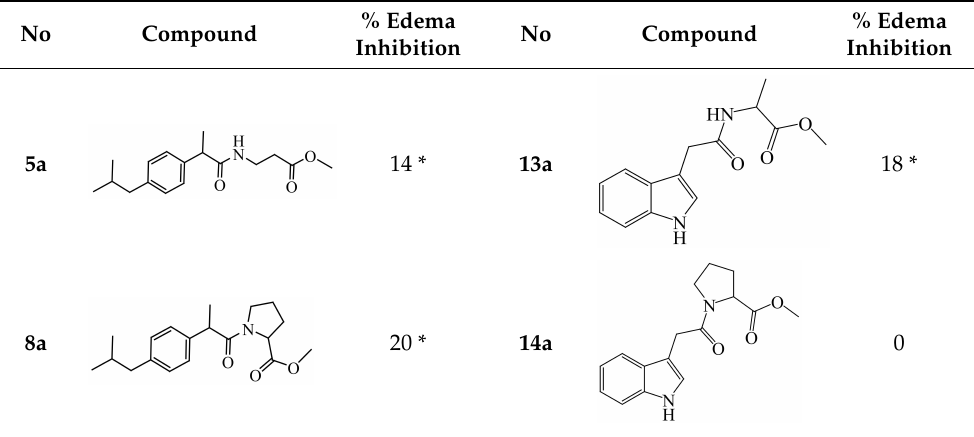
Table 2. Effect of methyl esters on carrageenan-induced rat paw edema. The effect on edema is expressed as percent inhibition of edema in comparison to controls, which received carrageenan only. All compounds were administered i.p. (0.15 mmol/kg). Each value represents the mean obtained from five female rats (160–180 g b.w.), and standard deviation is always within 10% of the mean